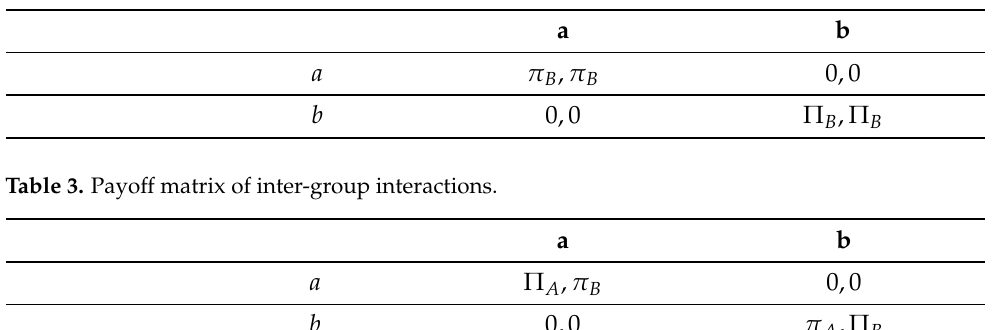
Table 2. Payoff matrix of interactions inside group B .